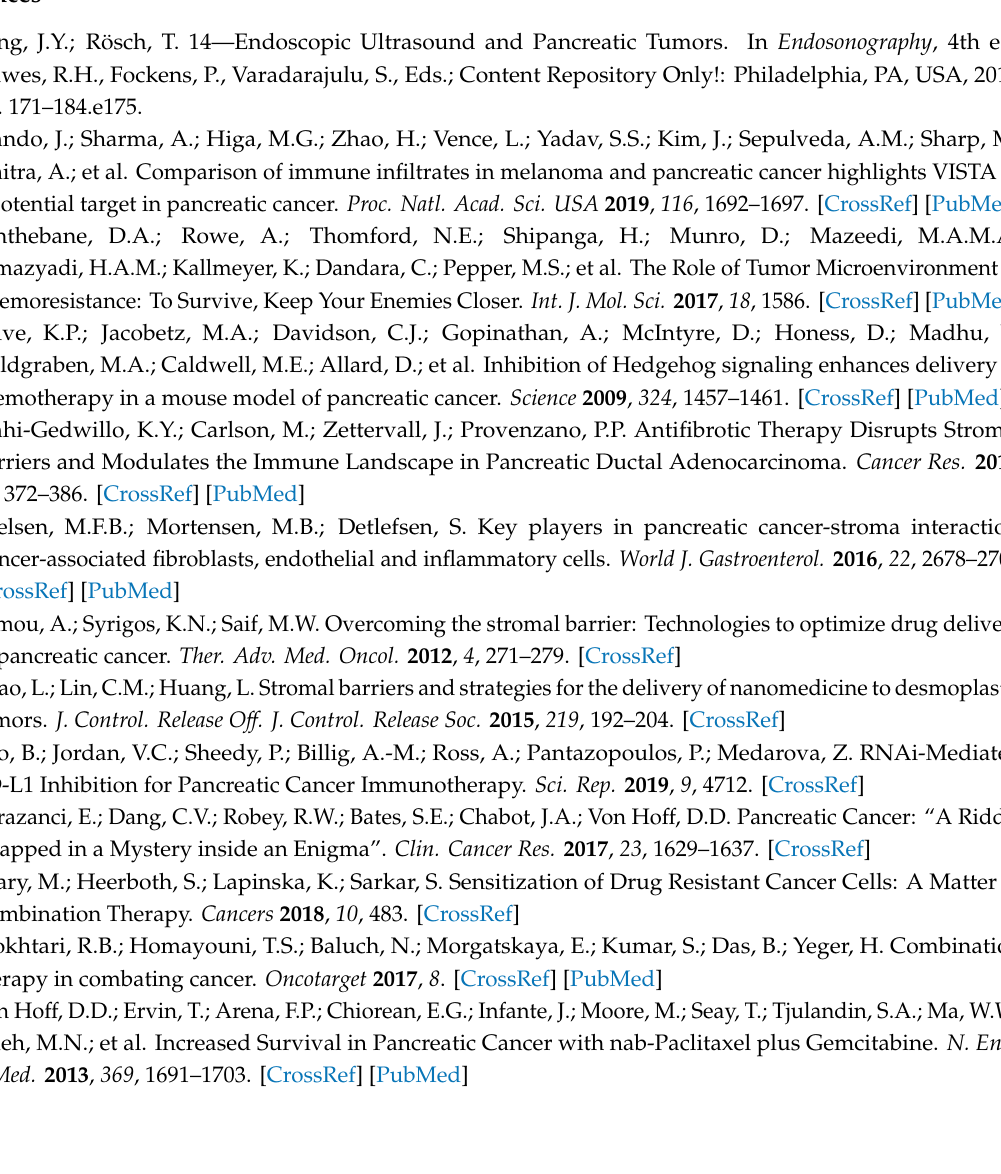
vehicle, Table S1: Stability studies of liposomes: stability of liposomes estimated by measuring size and PDI of liposomes in 10 FBS containing RPMI-1640 media at 0 h, 24 h, 48 h, and 72 h, respectively, Table S2: IC-50 values respective drugs in AsPC-1 and PANC-1 cells. Cells were treated with various (mentioned in table) drug-loaded TTP-conjugated Liposomes for 72 h, Table S3: In vivo treatment doses of each drug used in our